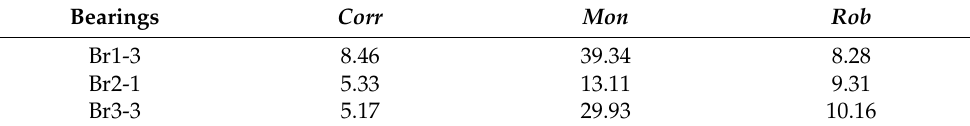
Table 4. Dispersion Coefficient. Table 5. Different feature subsets.